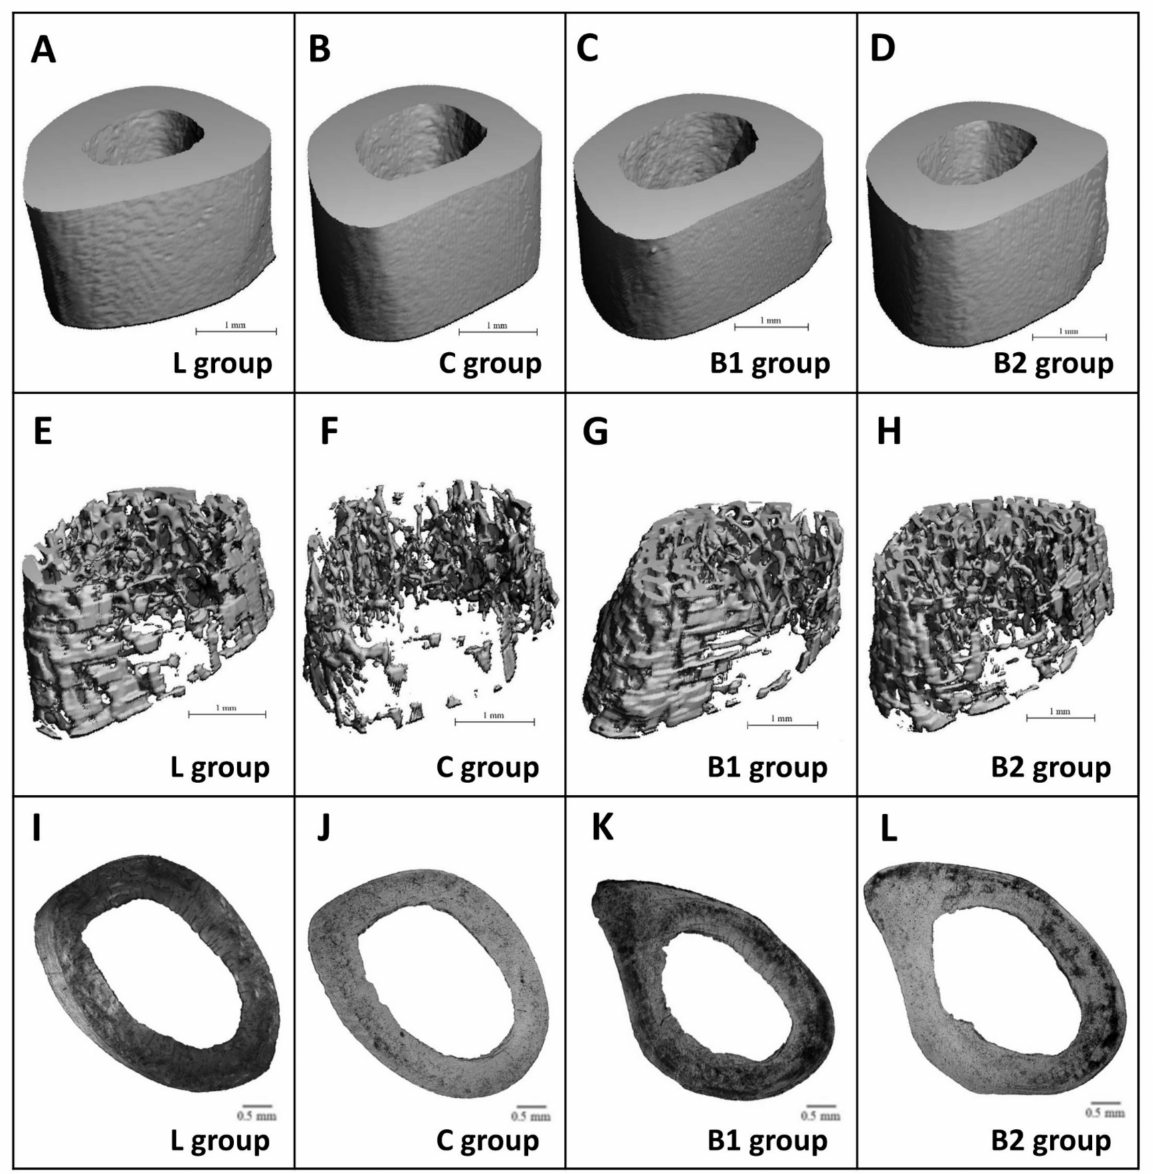
Figure 4. Representative 3D images of cortical ( A – D ) and trabecular bone tissues ( E – H ), and representative 2D images of the cortical bone ( I – L ) in ZDF